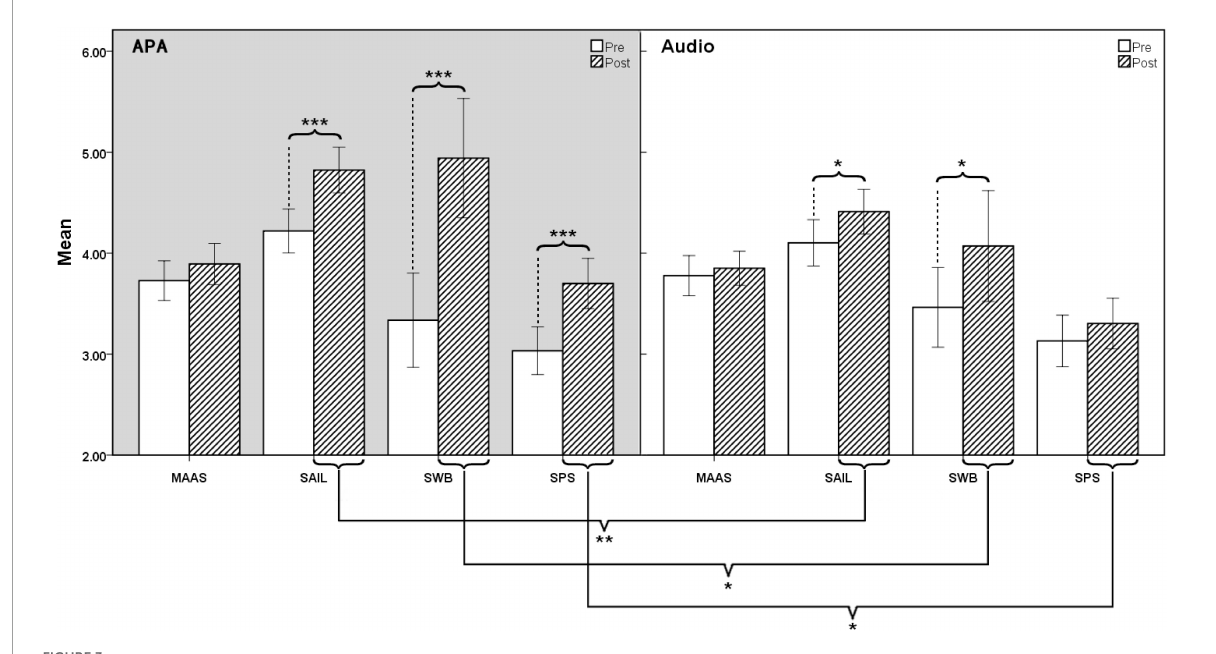
FIGURE3 Comparison of four measures between animated pedagogical agent (APA) and audio group. * p < 0.05; ** p < 0.01; *** p <